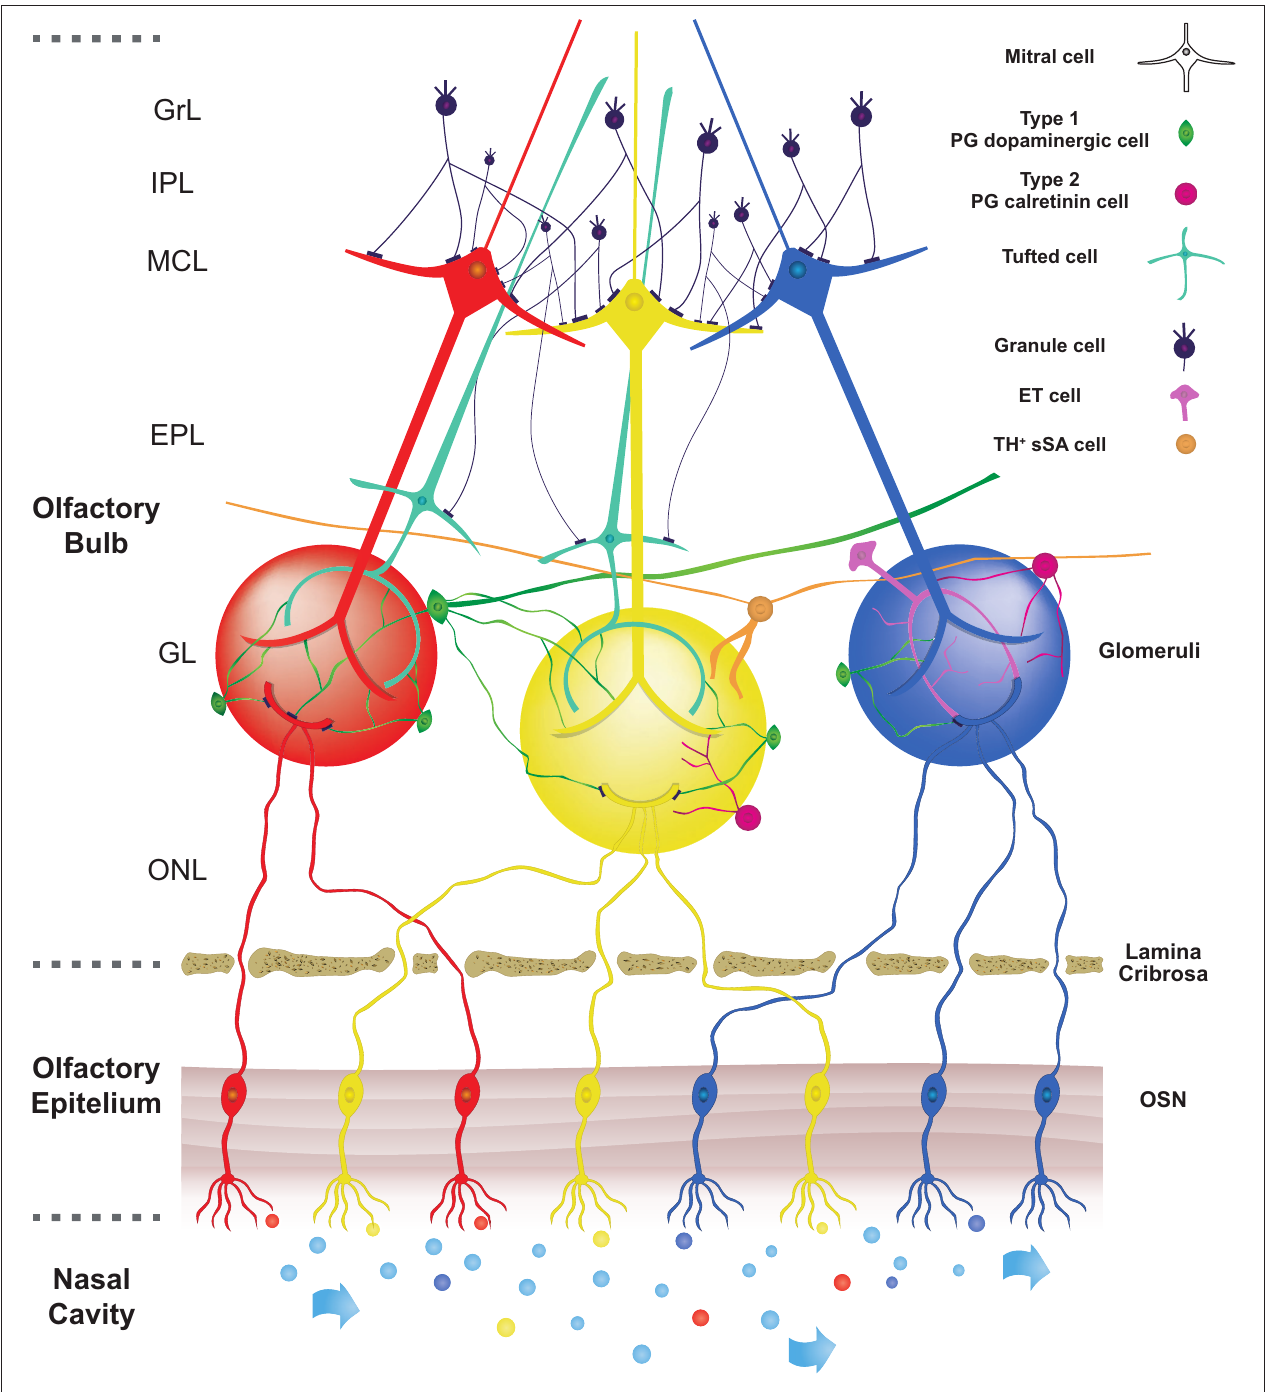
FIGURE 1 | Schematic pathway of the main neuronal connections in OB. In the nasal cavity, airflow transports different odorants (represented by different colours) to specific olfactory receptors expressed on olfactory sensory neurons (OSNs) localized in the olfactory epithelium (OE). Olfactory information is then transduced in an electrical signal to later reach the olfactory bulb (OB). Olfactory sensory neurons send their axons through the lamina cribrosa to reach the core of corresponding glomeruli, which consists of spherical structures located in the olfactory bulb. Axons of OSNs, expressing the same odorant receptors, are projected into the same glomeruli, so each glomerulus is linked to a single odorant receptor. Within the glomerular core, OSNs axons make synapses with apical dendrites of projections corresponding to OB neurons (Mitral and Tufted cells). On the surface of glomeruli are located periglomerular cells (PG). These cells project their dendrite into the glomerulus and make reciprocal synapses with projections neurons and some of them with axons of OSNs. Based on their synaptic connections with axons of OSNs, two subtypes of PG cells are described. Type 1 PG cells, belonging to dopaminergic PG cells, are synaptically connected both with axons of OSNs and dendrites of other neurons in the olfactory bulb. On the other hand, type 2 PG cells, belonging to calretinin PG cells, are not synaptically connected with axons of OSNs. The figure